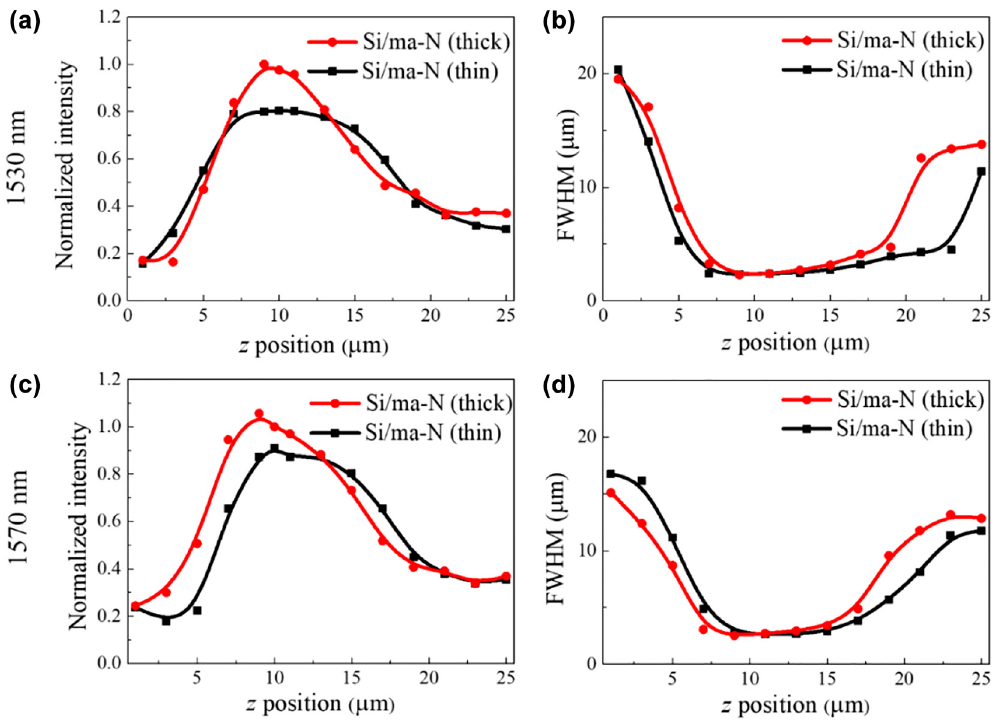
Figure 5: Characteristics of the thin (100 nm) and thick (140 nm) ma-N metalenses with a 10 μ m focal length. (a) Normalized peak intensity and (b) FWHM of the propagated beam at 𝜆 = 1530 nm. (c) Normalized peak intensity and (d) FWHM of the beam intensity at 𝜆 = 1570